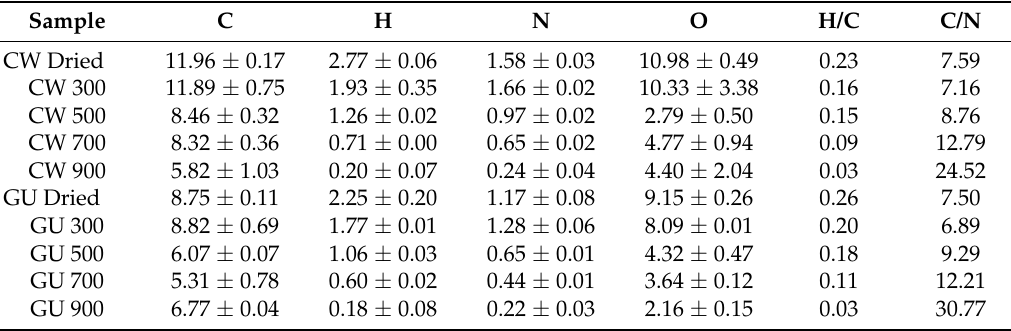
Table 2. Elemental composition analysis results for the dried and pyrolyzed byproducts of each water treatment